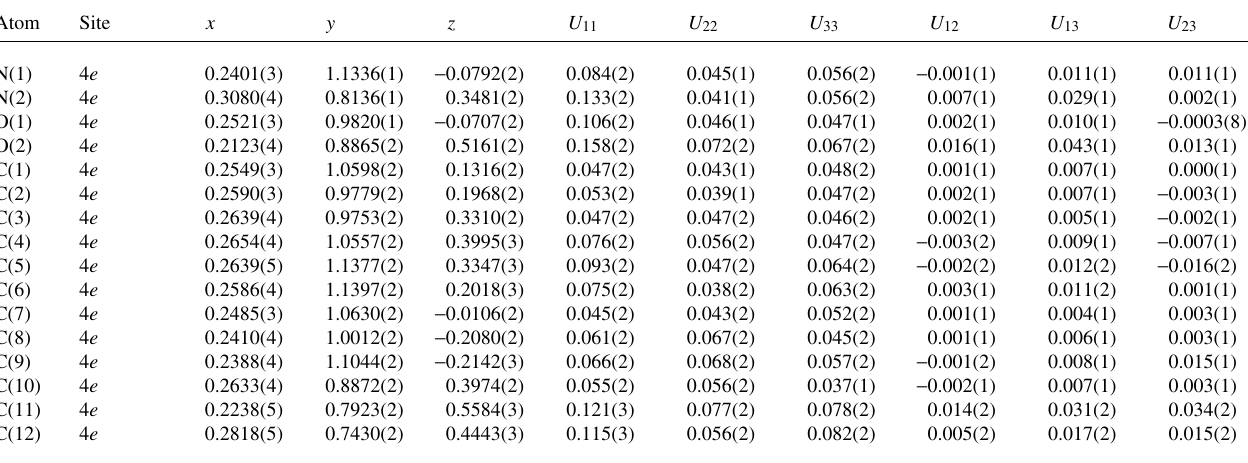
Table 3. Atomic coordinates and displacement parameters (in Å 2 )